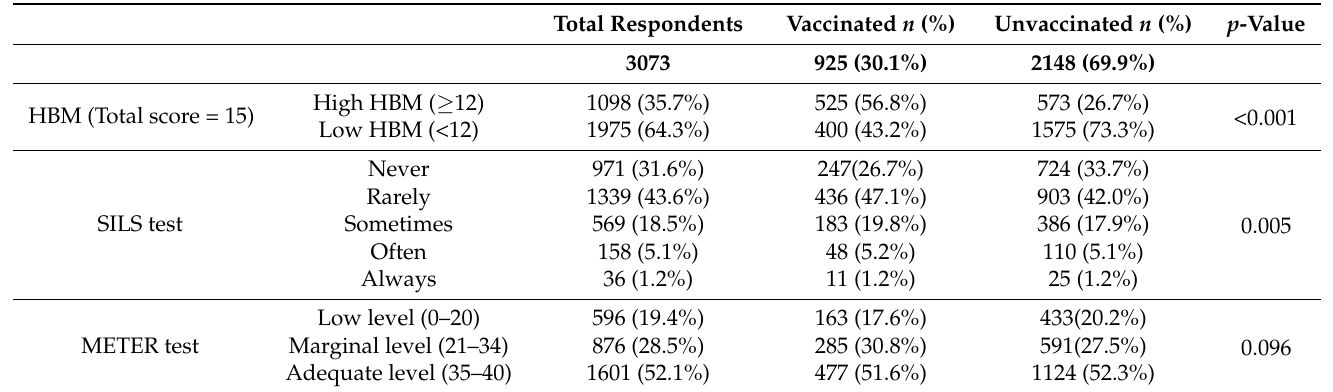
Table 3. HBM and HL scores, and differences between fully or not vaccinated for HPV.